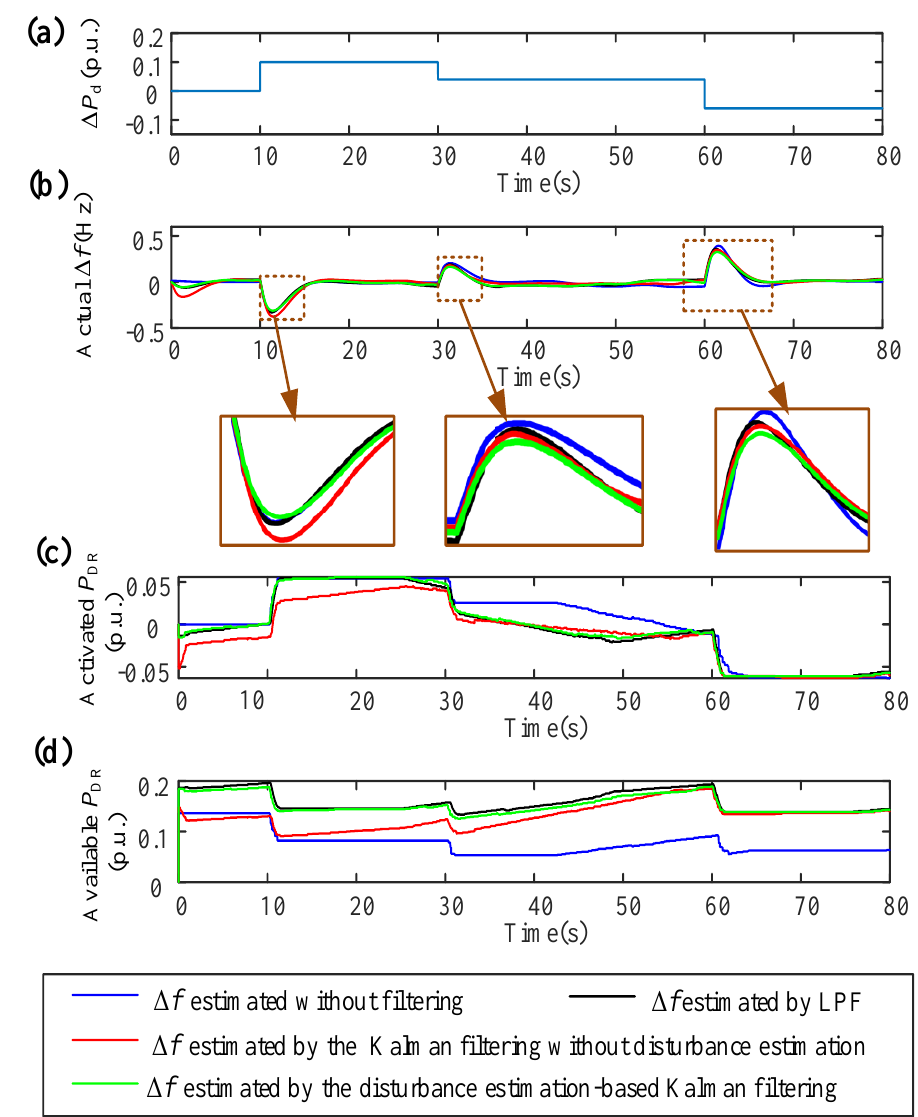
Figure 9. Comparison of frequency detection by different methods: ( a ) ∆ P d ; ( b ) actual ∆ f; ( c ) activated DR appliances; ( d ) available DR appliances.